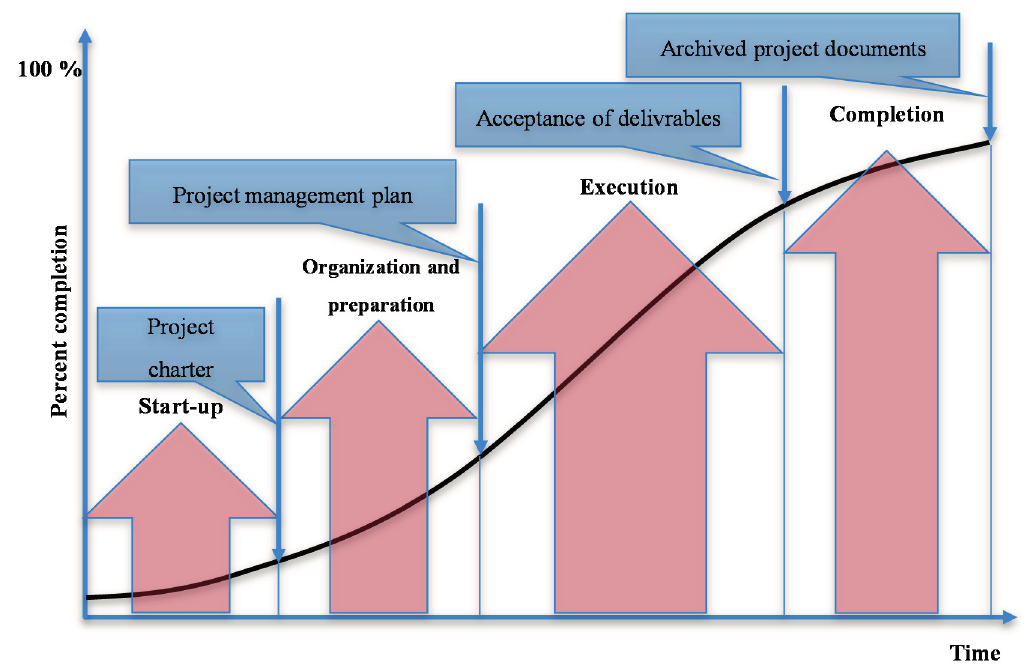
Figure 2. Lifecycle of a project. Adapted from the PMBOK ® Guide